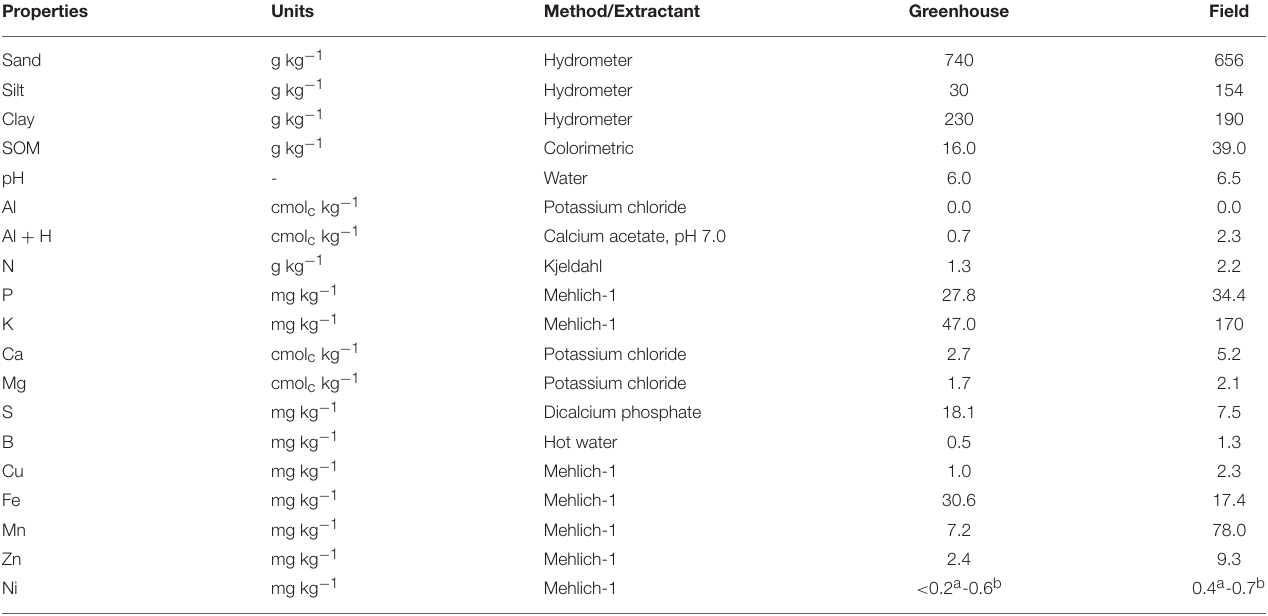
TABLE 2 | Chemical characterization and particle size distribution before sowing of the native forest soil Latossolo Vermelho Amarelo distrófico típico (Oxisol) used in the greenhouse experiment and the cultivated soil Latossolo Vermelho Amarelo eutrófico típico (Oxisol) used in the field experiment.